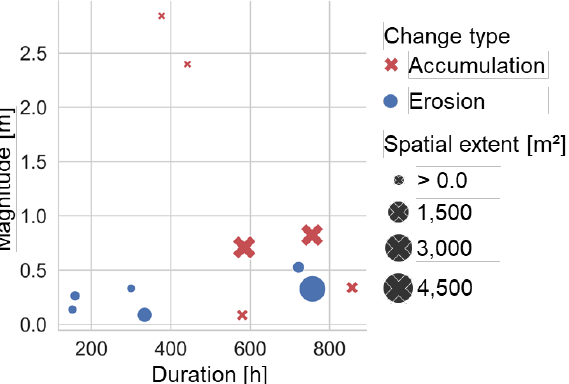
Figure 4. Spatial and temporal change properties of twelve 4D objects-by-change that are used for analysis of spatiotemporal segmentation with reduced